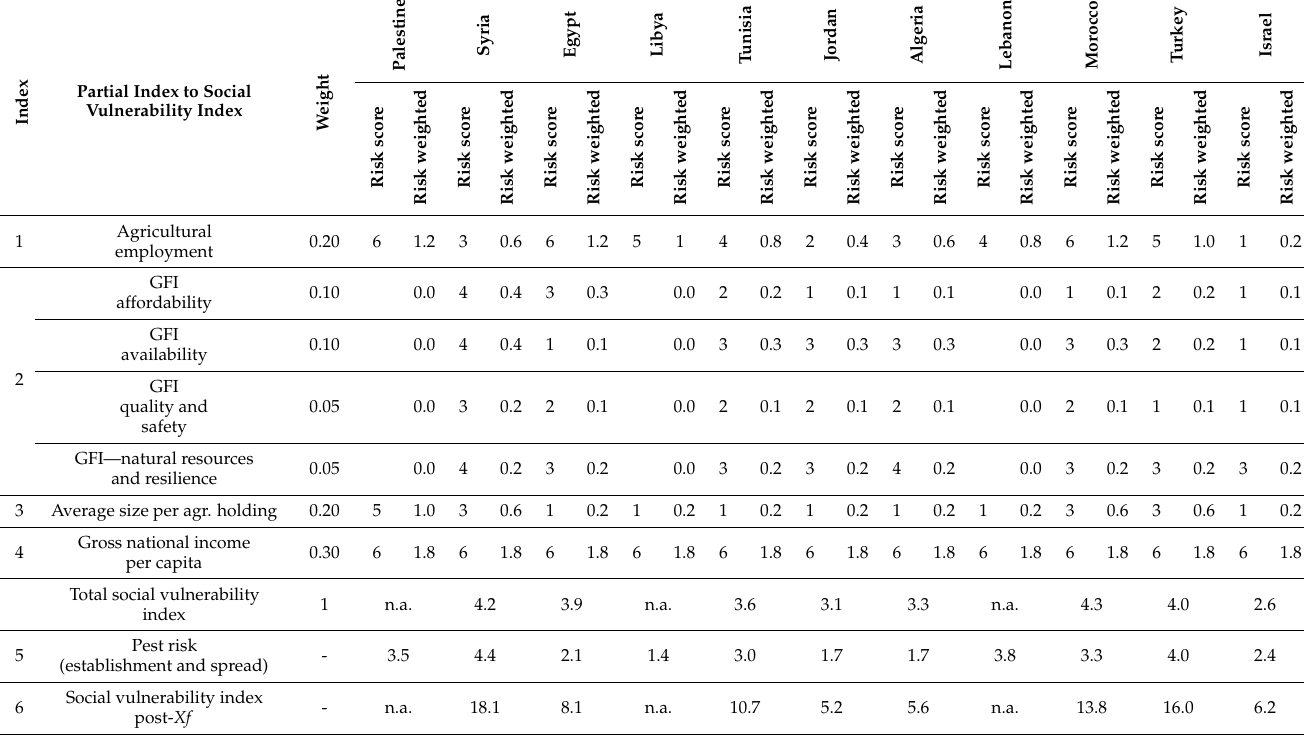
Table 5. Assessment of the social vulnerability index due to Xylella fastidiosa on olives, grapes, Citrus spp., and almonds in the Middle East and North Africa countries (Year: 2019).